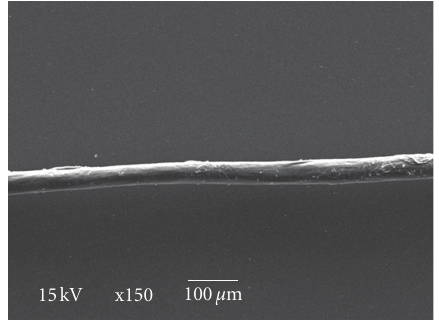
Figure 3: Treated Egyptian white wool fiber ( × 150).